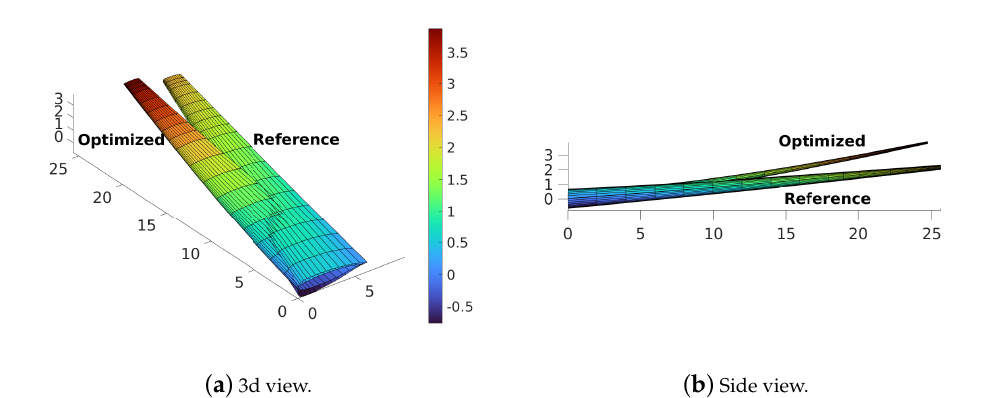
Figure 19. Backward-wing aircraft aeroelastic deformation at cruise.